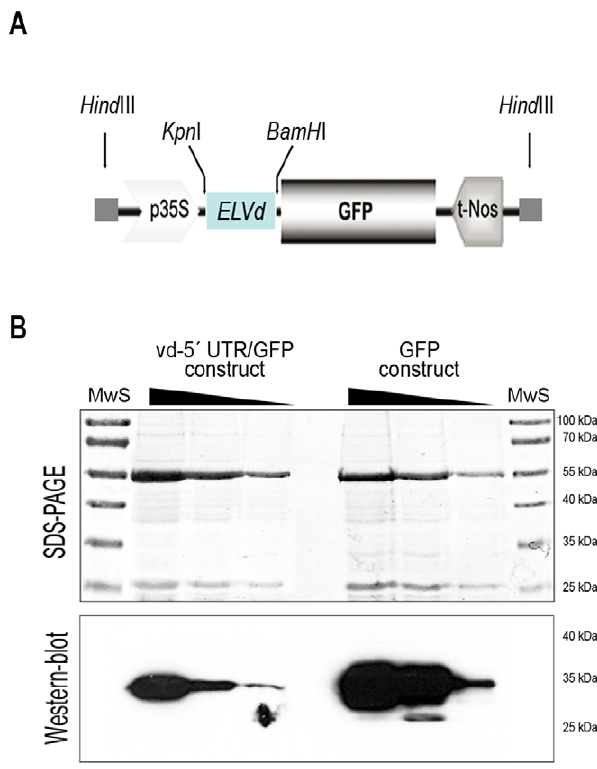
Figure 1. Transcriptional fusion of viroid derived 5 9 UTR end to GFP cDNA. ( A ) Physical map of the vd-5 9 UTR/GFP construct. ( B ) Serological detection of the vd-5 9 UTR/GFP. Total proteins were extracted from infiltrated leaves, electrophoresed in 10% SDS-PAGE (upper panel) and blotted for serological detection (lower panel). The vd-5 9 UTR/GFP and the GFP were clearly detected and show similar relative electrophoretic mobility, indicating that the viroid derived sequence acts as a true untranslated RNA. Three 1:5 serial dilutions are sown for each construct. MwS: Molecular weight standard.